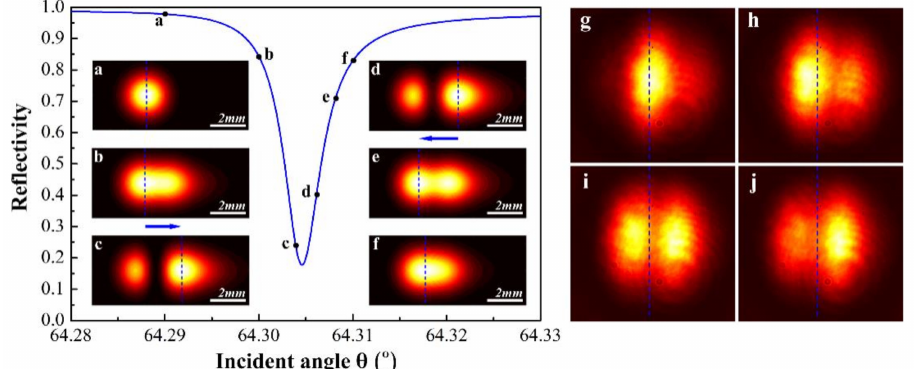
Figure 3. The discrete Goos-Hänchen shift effect of a Gaussian beam due to the UOMs coupling. ( a – f ) Simulated light patterns within a single resonant dip, where a M-line divided the light profile into two separated parts near resonance. The blue lines mark the position of the intensity peaks. ( g – j ) Experimentally measured results confirm the discrete negative and positive shift during a specific UOM coupling, where the blue dashed lines mark the position of the initial beam center in ( g ) for better